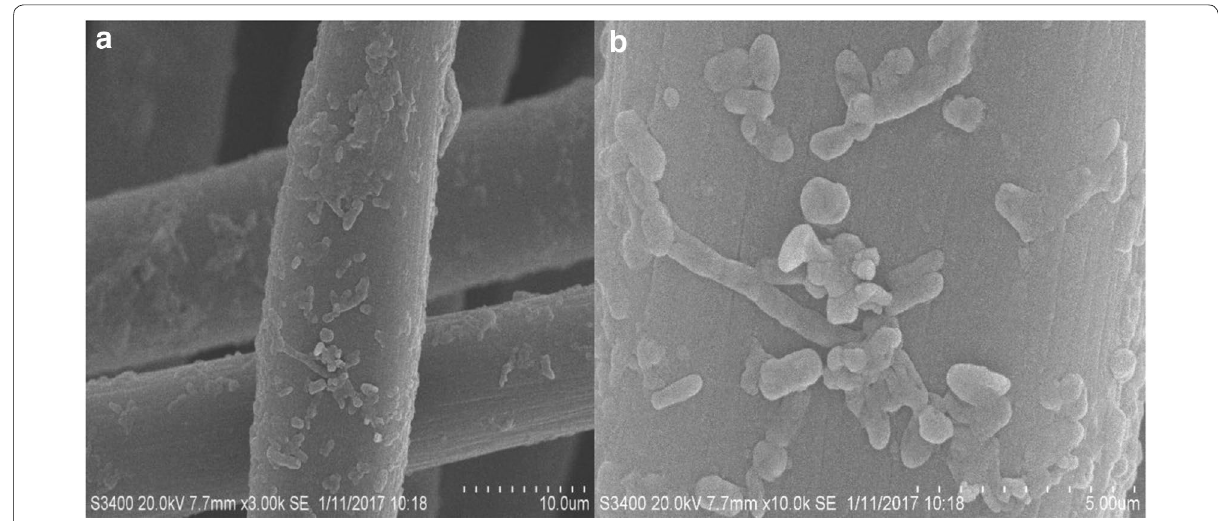
Fig. 3 SEM ( a , b ) of C. scatologenes ATCC 25775 after microbial electrosynthesis experiments ended in low and high scale,